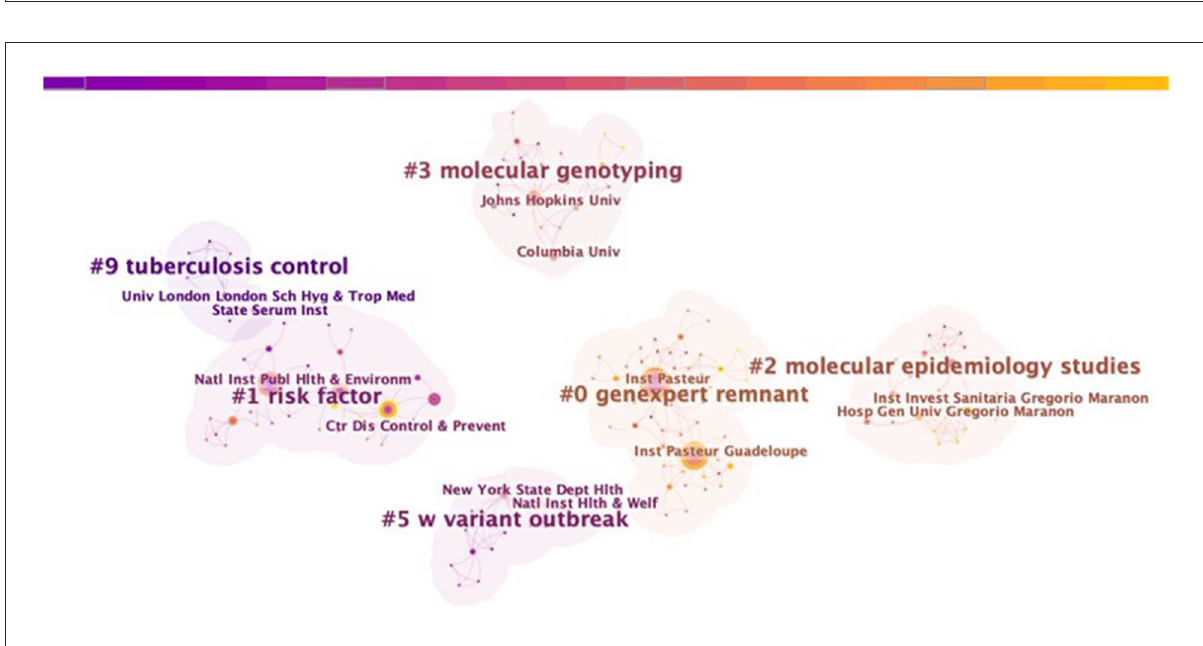
FIGURE3 Clustered network of co-institution analysis on tuberculosis molecular